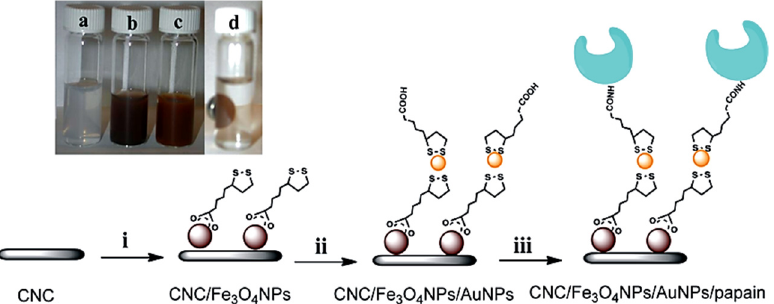
Figure 20. The schematic presentation of the stepwise formation of the conjugate of CNC/Fe 3 O 4 NPs/AuNPs/Papain—( i ) FeCl 3 , FeCl 2 , thioctic acid; ( ii ) HAuCl 4 , α -cyclodextrin, NaBH 4 , thioctic acid; ( iii ) EDC, NHS, papain. Inset shows photographs of ( a ) pristine CNC; ( b ) CNC/Fe 3 O 4 NPs; ( c ) CNC/Fe 3 O 4 NPs/AuNPs; and ( d ) CNC/Fe 3 O 4 NPs/AuNPs attracted to the sidewall with a permanent magnet. Reprinted with permission from [ 354 ] . Copyright 2013 American Chemical Society.